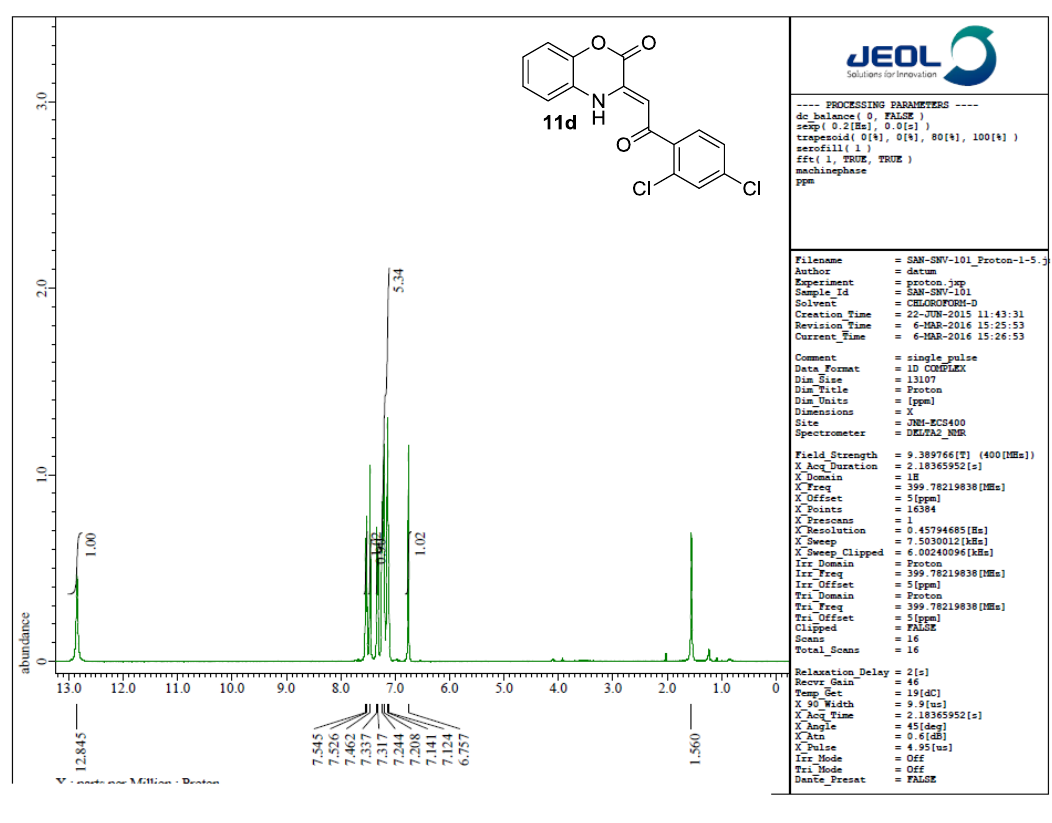
Figure 7 . 1 H NMR Spectra of Compound 11d .